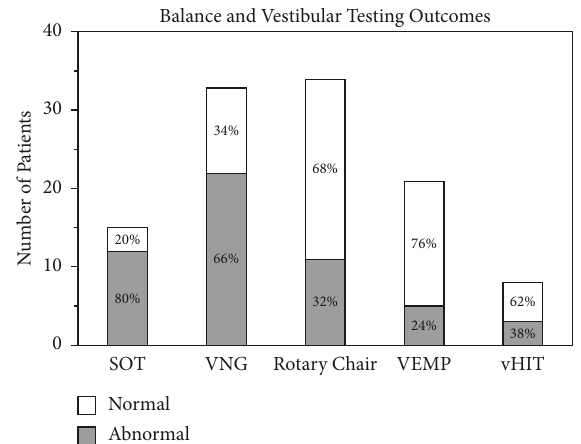
Figure 1: Bar chart depicting the testing outcome, reported as the percent of patients scoring abnormally (dots) or normally (stripes) for each test. From left to right, the percentage of patients that scored abnormally in each test is as follows: 80%, 66%, 32%, 24%, and